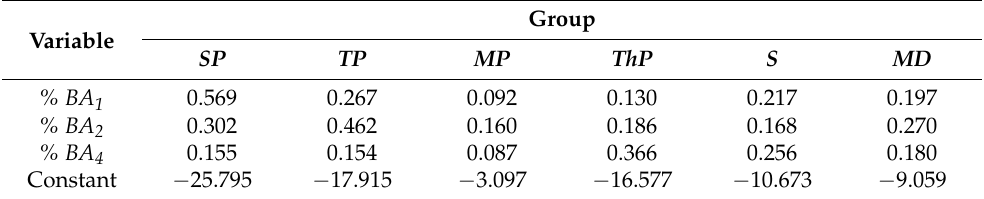
Table 3. Fisher classification functions for first DA ( SP : Seedling Poles; TP : Thin Poles; MP : Medium Poles; Th : Thick Poles; S : Stratified; MD : Multi-diameter).